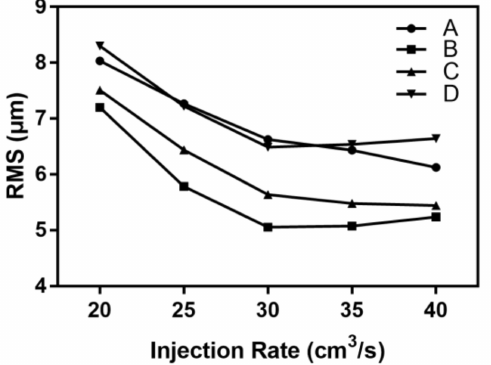
Figure 11. The influence of the injection rate on the RMS of the microchannel.